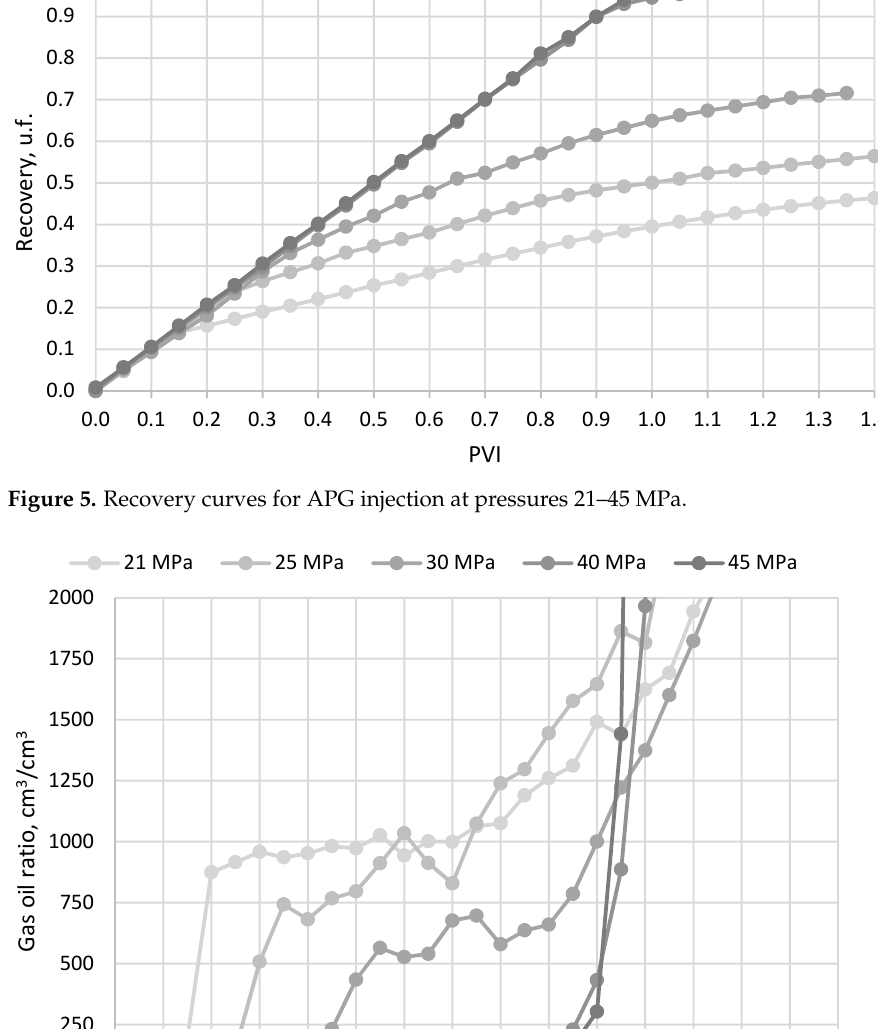
Figure 5. Recovery curves for APG injection at pressures 21–45 MPa.